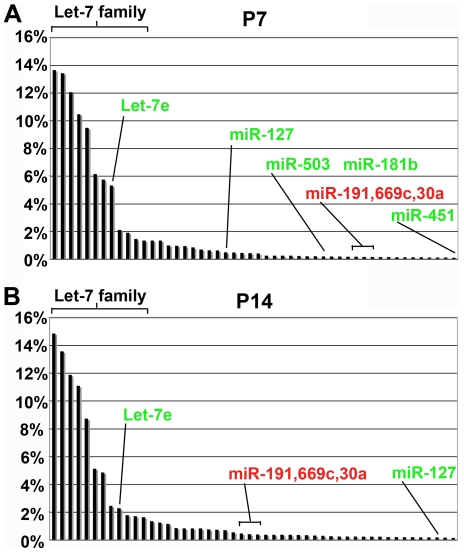
The MicroRNA signature of the testis differs over prepubertal development.MicroRNA signature of postnatal day 7 (P7) (A) and 14 (P14) (B) testes. The top 25 miRNAs (by percent read abundance) at each age were plotted. Representative miRNAs are labeled with those with greater abundance at P7 (putative spermatogonial role) in green and at P14 (putative spermatocyte role) in red. Levels at P10 were intermediate between P7 and P14 indicating a lack of miRNAs specific to meiotic initiation. ∼80% of all miRNAs in the testis at all three time-points were let-7 family miRNAs.